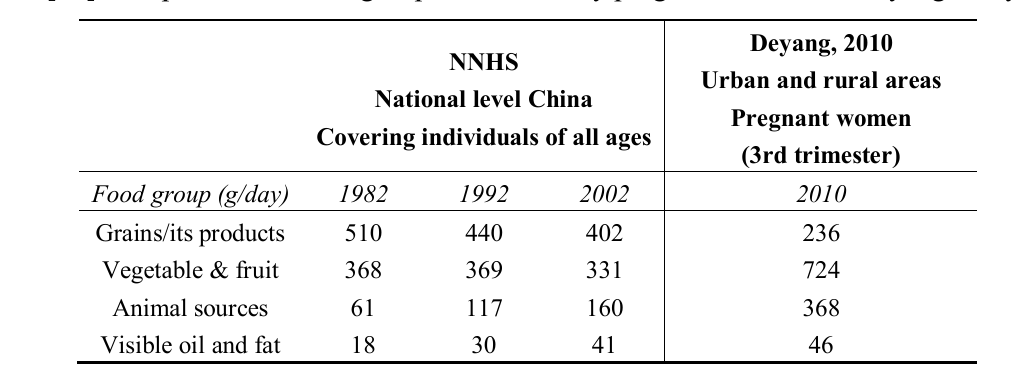
Table 6. Average food consumption by the Chinese population in 1982, 1992, and 2002 [20], compared with food groups consumed by pregnant women in Deyang